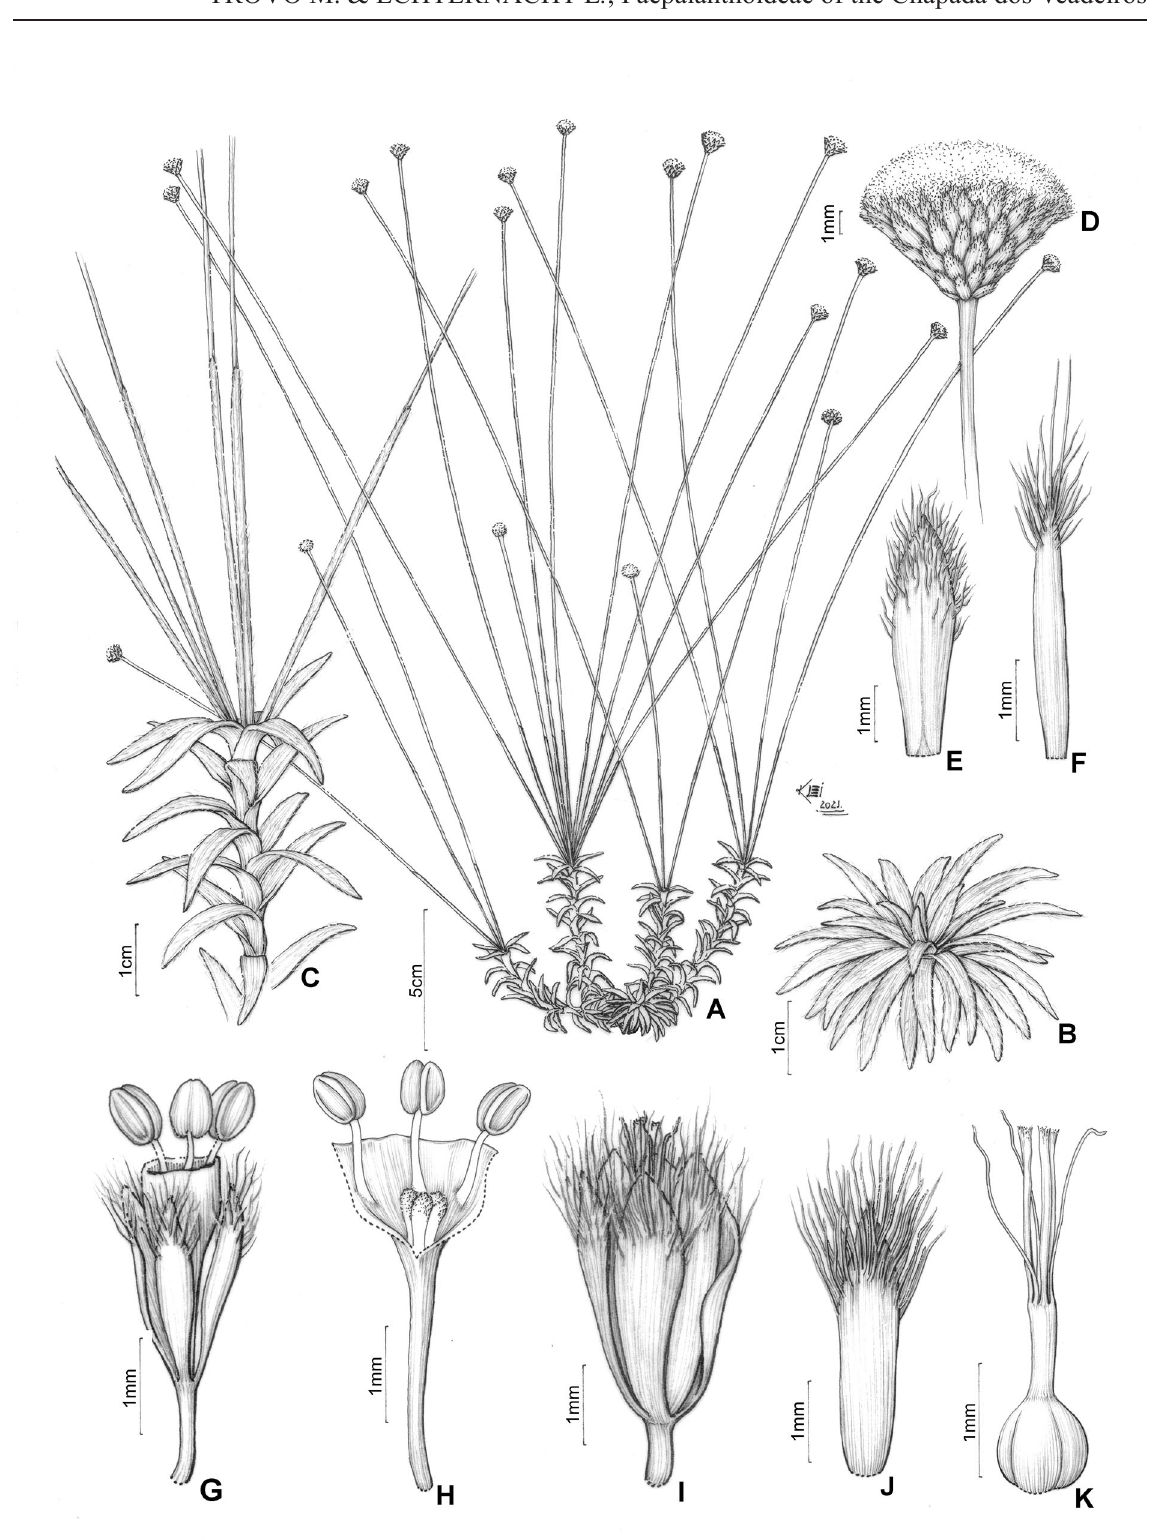
Fig. 2. Actinocephalus brevifolius Trovó & Echtern. sp. nov.. A . Habit. B . Rosette detail. C . Paraclade apex detail. D . Capitulum detail. E . Involucral bract, abaxial surface. F . Floral bract, abaxial surface. G . Staminate flower. H . Staminate flower with sepals removed and corolla opened. I . Pistillate flower. J . Petal of the pistillate flower, abaxial surface. K . Gynoecium. ( M.L.O. Trovó et al. 774 –